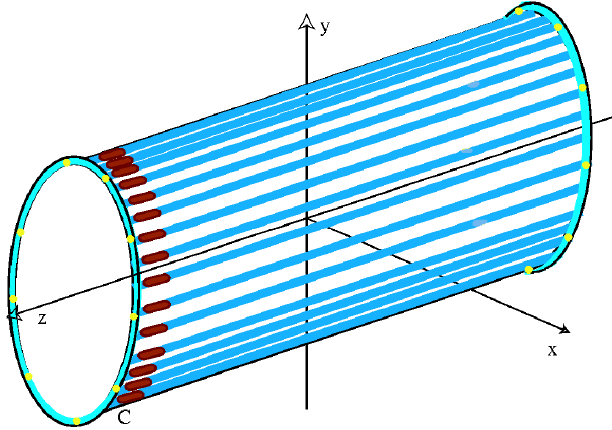
FIG. 1. (Color) The ceramic chamber covered in Cu stripes equipped with capacitors. There are flanges on both sides of the chamber to fix it along the ring. The brown objects denote capacitors, which are associated on Cu stripes to realize the high impedance for the induced current with the frequency compo- nents of the external time-dependent magnetic field and the low impedance for the circulating beam. This kind of chamber is usually used in a rapid cycling synchrotron